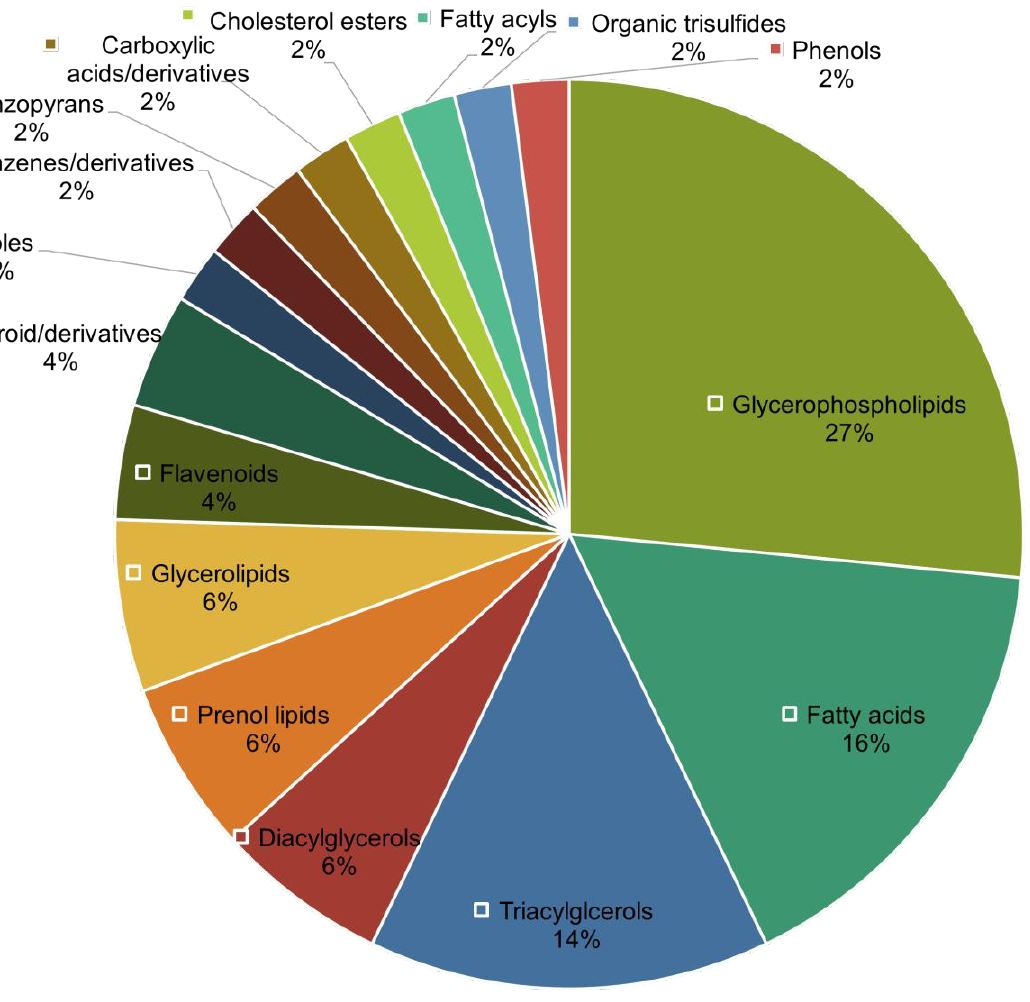
Figure 2. Distribution of lipid classes of annotated significant lipidomic features. Table 3. List of annotated significantly altered lipidomic features.